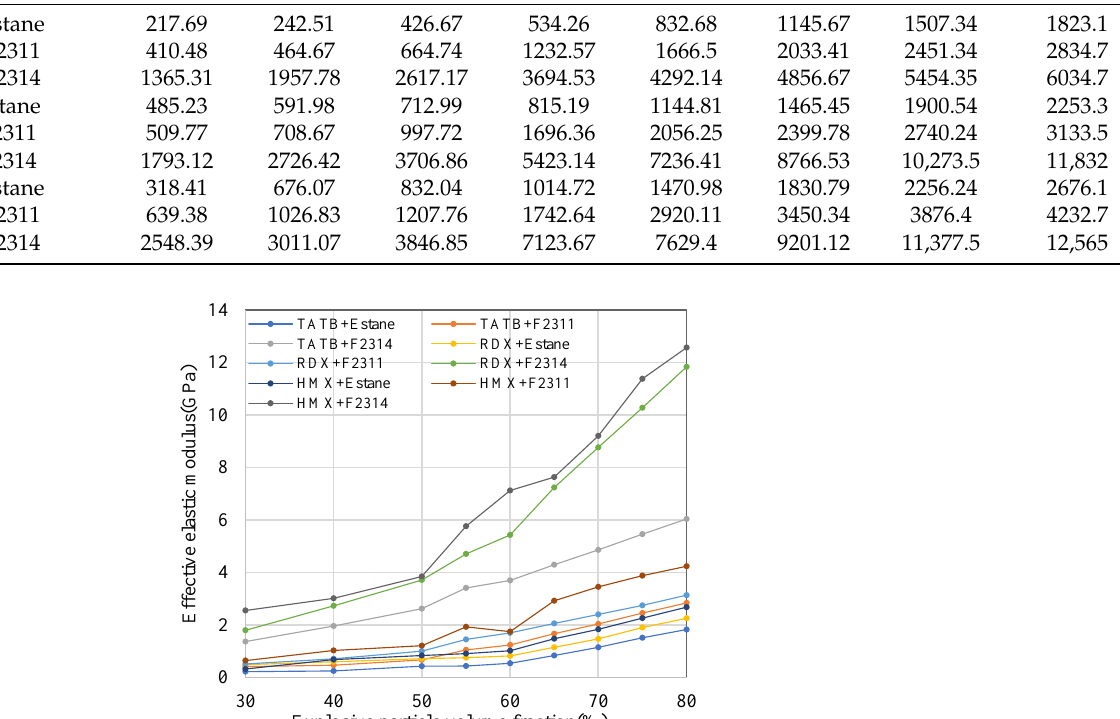
Table 2. Effective elastic modulus of the polymer-bonded explosives (PBX) with different explosive particles and binder. Explosive Composition TATB+Estane 1823.1 TATB+F2311